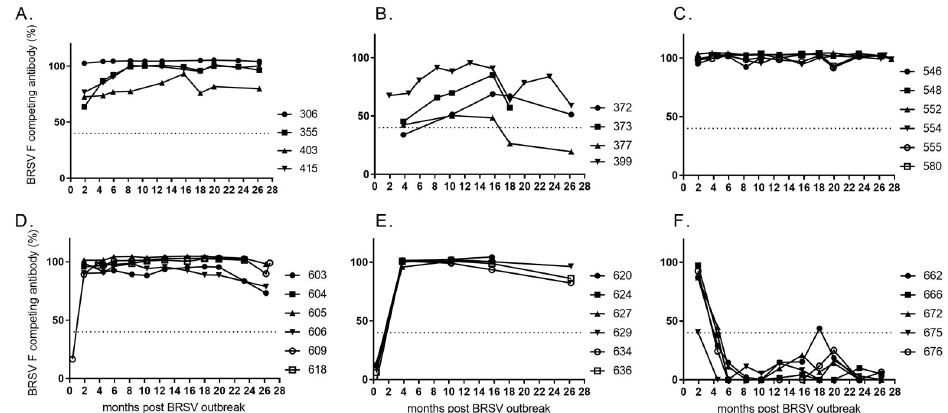
Fig 5. Kinetics of HRSV-F-reactive serum antibodies in cattle of different age and production status. At the time of a BRSV outbreak the cattle were (A) 23–30 months old ( < 6 months gestation), (B) 24–26 months old ( > 6.5 months gestation), (C) 7–11 months old, (D) 4–5 months old, (E) 2–3 months old, or (F) born during or just after the outbreak in January 2016 (month 0). Data are presented as competition percentage. The limit of detection is presented as a dotted line.